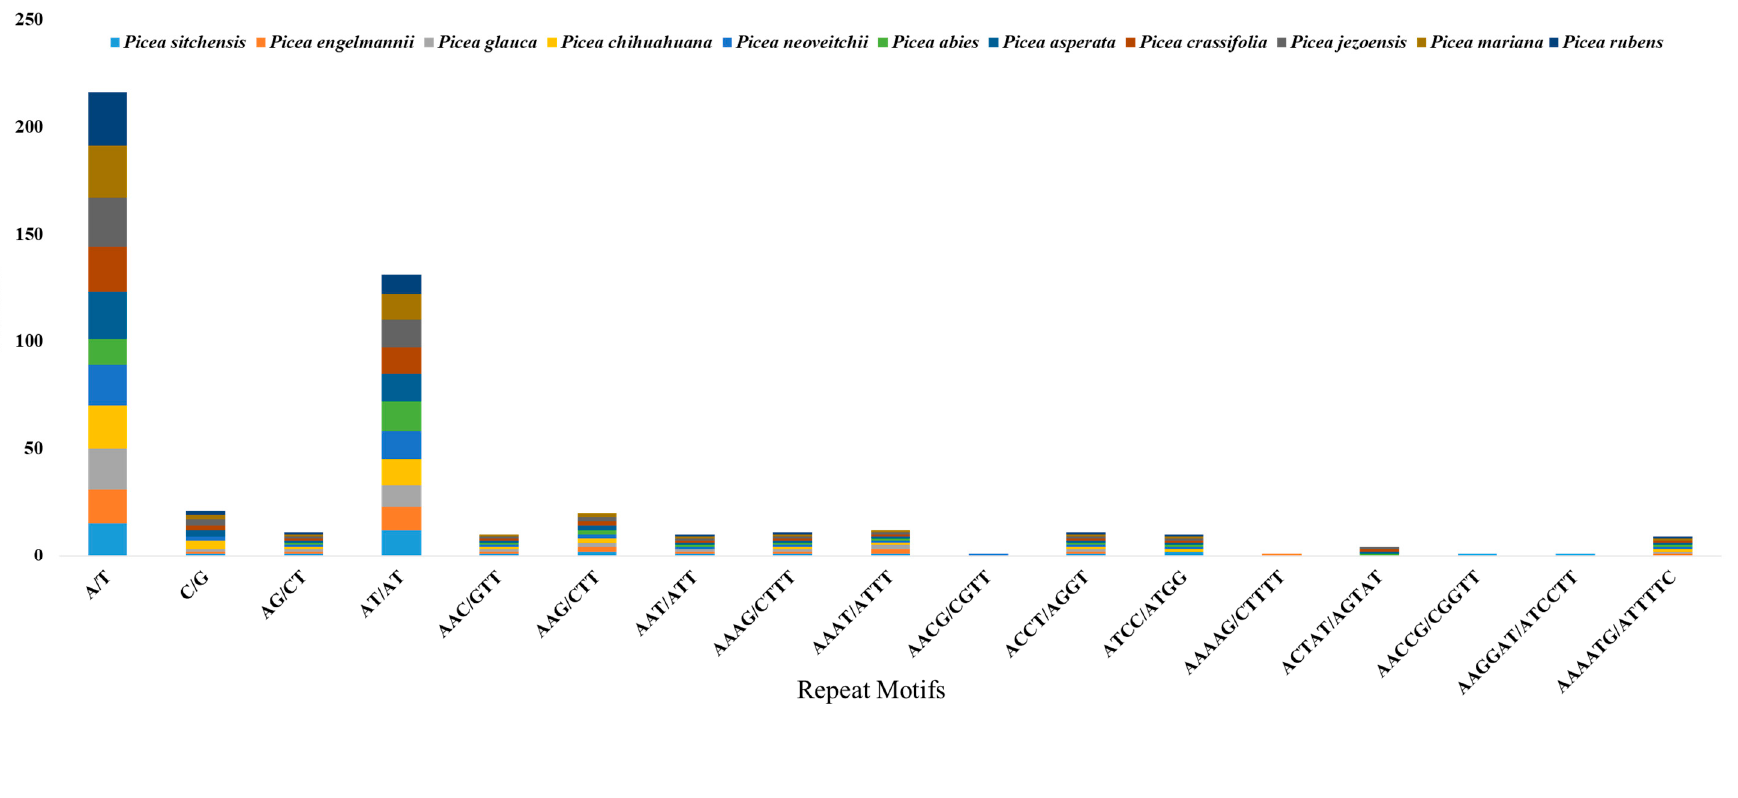
Figure 3. ( a ) Patterns of the number of microsatellites repeats in the chloroplast genomes of Picea sitchensis , P. engelmannii , P. glauca , P. chihuahuana , P. neoveitchii , P. abies , P. asperata , P. crassifolia , P. jezoensis , P. mariana , and P. rubens . ( b ) Repeat motif distribution in the chloroplast genomes of Picea sitchensis, P. engelmannii , P. glauca , P. chihuahuana , P. neoveitchii , P. abies , P. asperata , P. crassifolia , P. jezoensis , P. mariana , and P. rubens .